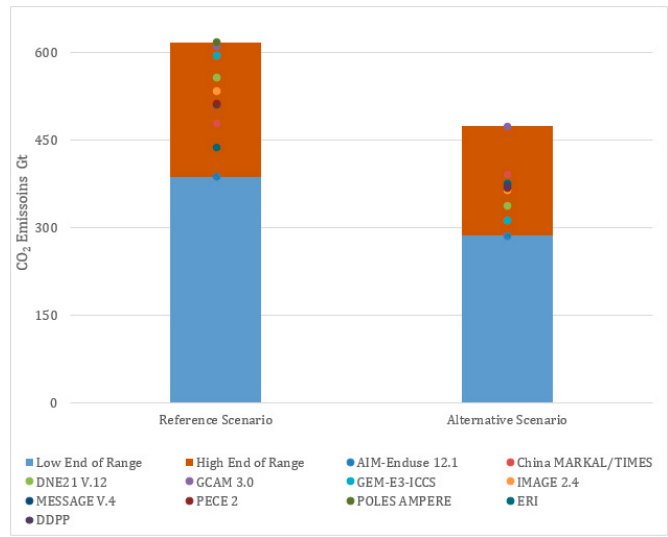
Figure 3. Comparison of cumulative emissions in 2050 under Reference Scenarios and Alternative Scenarios. Note: Cumulative emissions are calculated by linearly interpolating projected emissions levels from